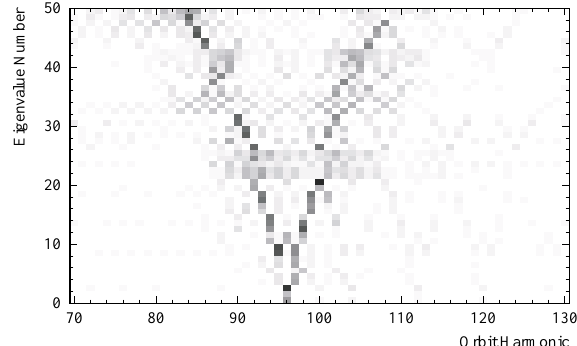
FIG. 5. Harmonics of the normalized vertical orbit eigenvec- tors (cid:1) w 1 (cid:2) y (cid:1) i (cid:2) (cid:4) w i (cid:2) for the 50 largest eigenvalues as a function of the eigenvalue number (ordered by decreasing eigenvalue). The strength of the harmonics increases from white to black. The vertical integer tune is